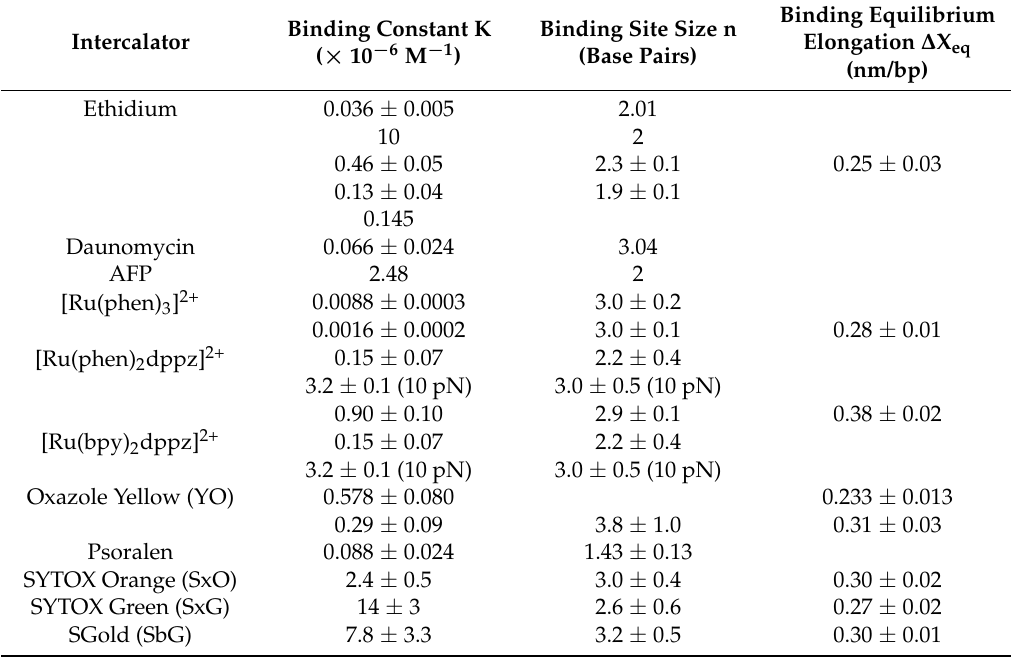
switch effects on the G-quadruplex and I-motif DNA, while [Ru(bpy) 2 (dppz)] 2+ had light